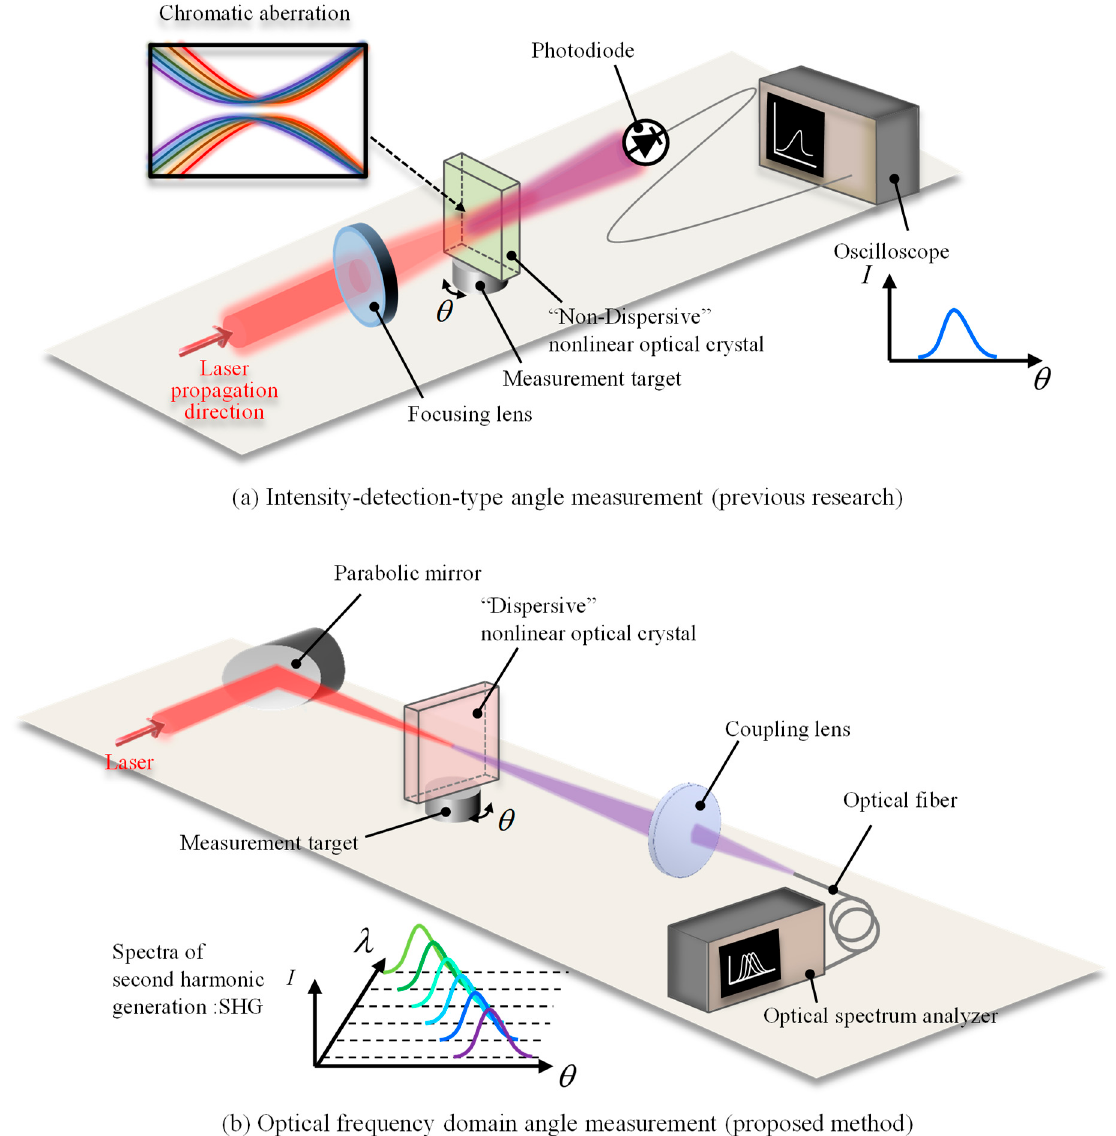
Figure 1. ( a ) A schematic of the previous research. ( b ) A schematic view of this research.